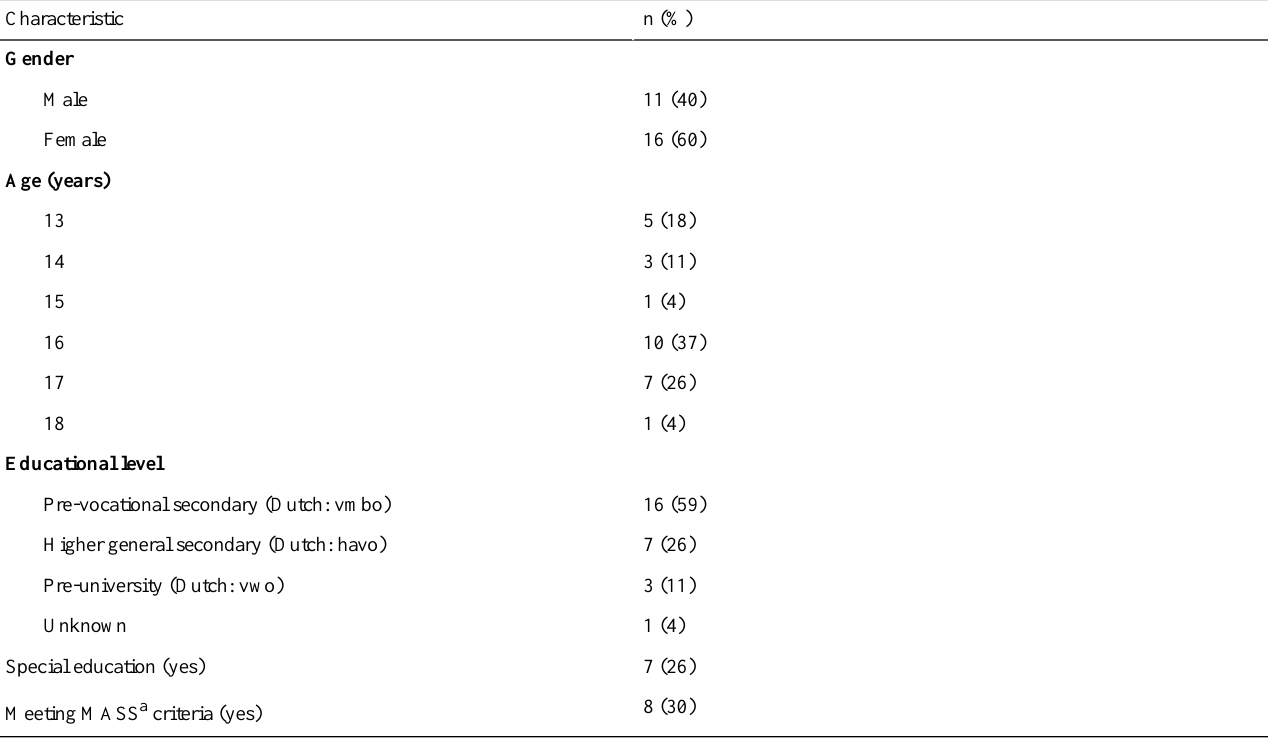
Table 2. Sample characteristics of students